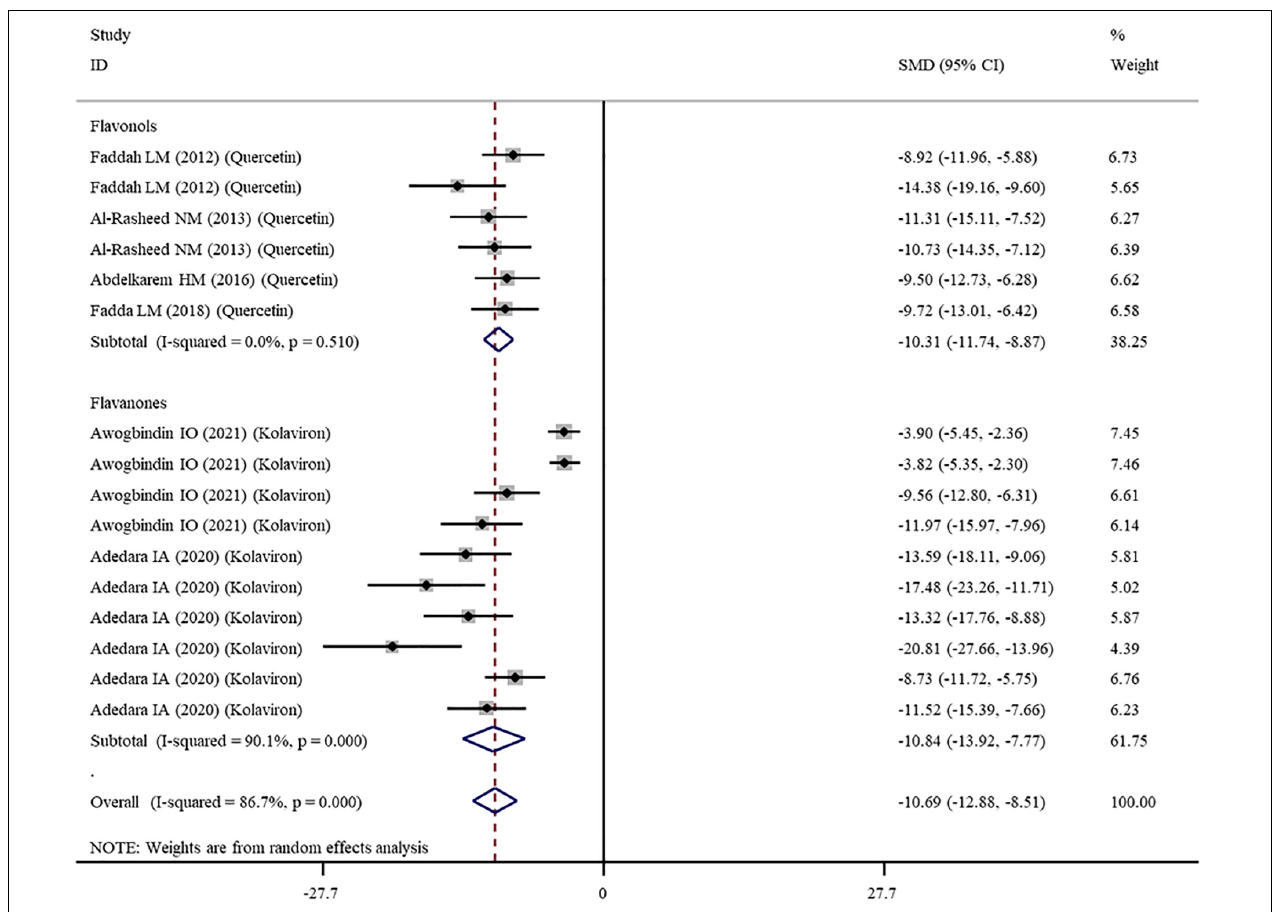
FIGURE 5 | Forest plots to show the effects of flavonoid supplementation on NO levels compared with the nanomaterial exposure group. NO, nitric oxide; SMD, standardized mean difference; CI, confidence